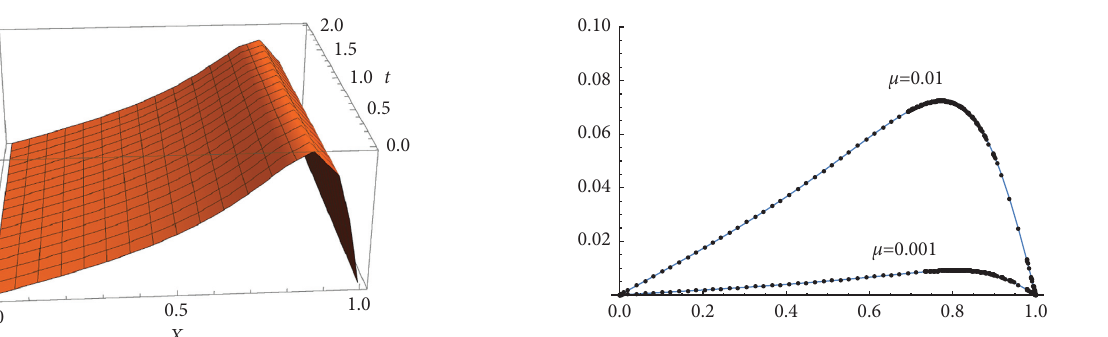
� 1 (a) and T � 3 (b) for Example 2. 0 0